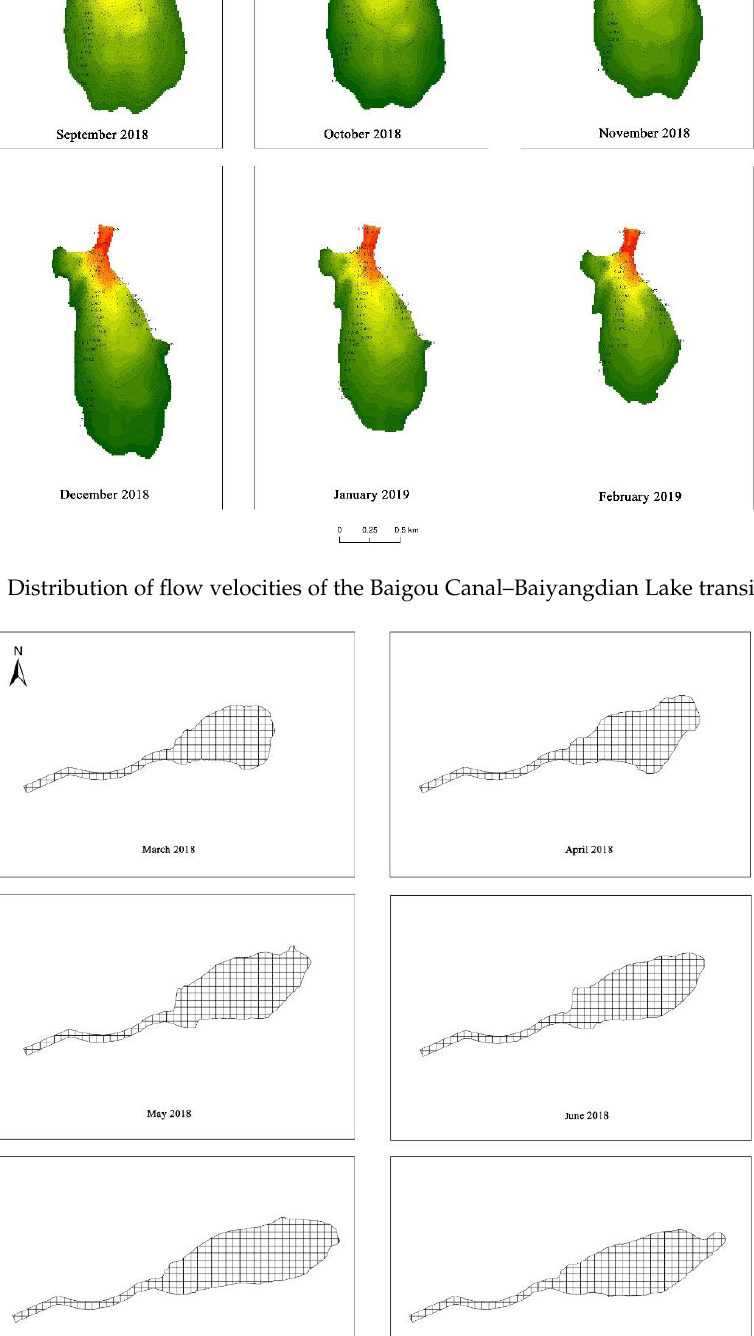
Figure A3. Areas of the Fu River–Baiyangdian Lake transition zone in each month. Numeric values are provided in Table 4.